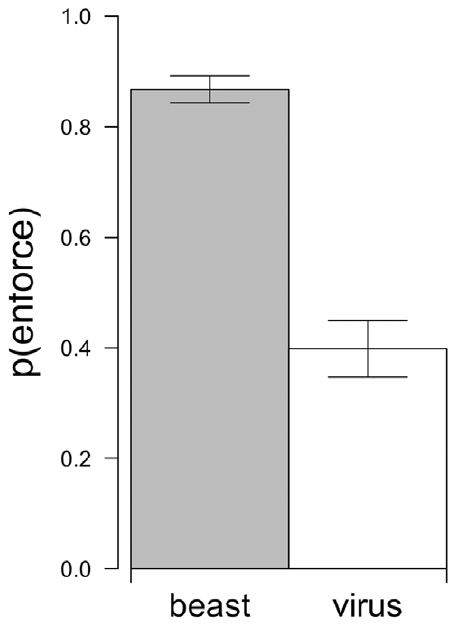
Figure 1. Explicit metaphor comparison. People in Experiment 1 were more likely to associate enforcement-oriented responses with the ‘‘beast’’ metaphor than the ‘‘virus’’ metaphor. Error bars represent the standard error of the proportions.